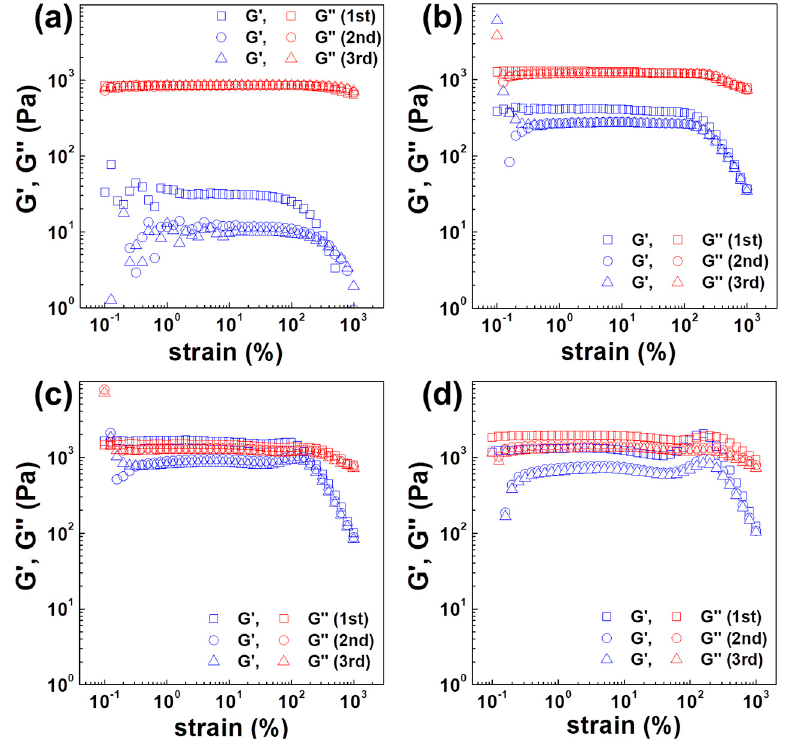
Figure 5. Change of storage and loss moduli during strain sweep test for PC/ABS blend ratio of ( a ) 10:0, ( b ) 7:3, ( c ) 3:7 and ( d ) 0:10.